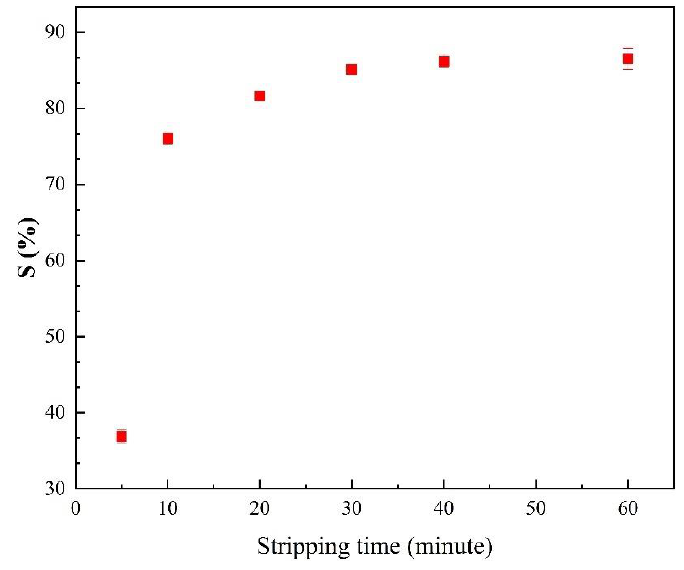
Figure 12. Effects of stripping time under the conditions: [oxalic acid] = 1 mol/L, stripping temperature = 313 K, and phase ratio = 1:1.